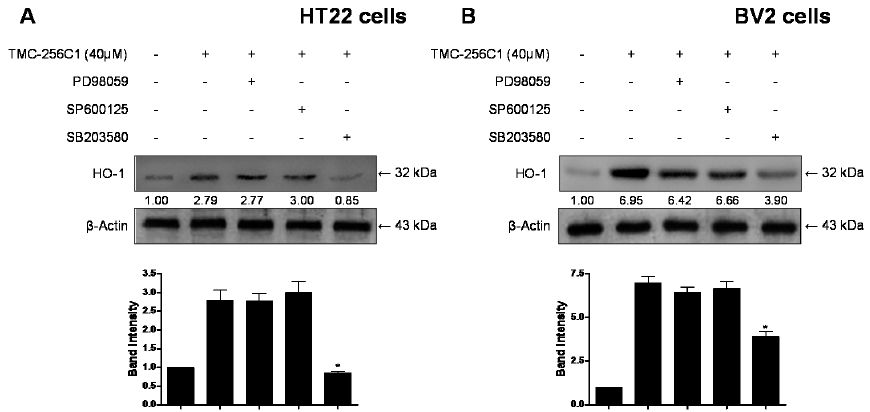
Figure 10. Effects of p38 activation induced by TMC-256C1 on HO-1 expression in HT22 cells ( A ) and BV2 cells ( B ). Cells were pre-treated for 1 h with the specific inhibitors, PD98059 (40 μ M), SP600125 (25 μ M), and SB203580 (20 μ M), and then treated with TMC-256C1 (40 μ M) for 12 h. Band intensity was quanti fi ed by densitometry and normalized to β -actin, and the normalized values are presented at the bottom of each band. The data shown, representative of three independent experiments, are the mean values of three experiments ± SD. * p < 0.05 compared to the group treated with LPS.